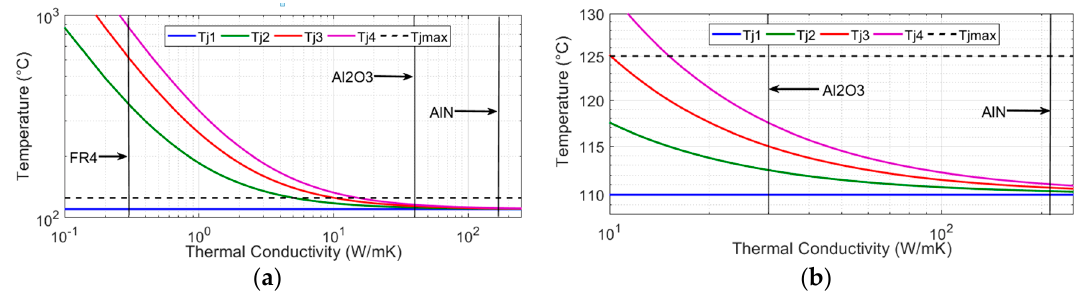
Figure 20. Junction temperature increase among the series-connected devices as a function of the thermal conductivity ( a ) and its zoomed view ( b ) for P s = 60 W, T j = 110 °C, T a = 25 °C, and R thjc = 0.1/°C.